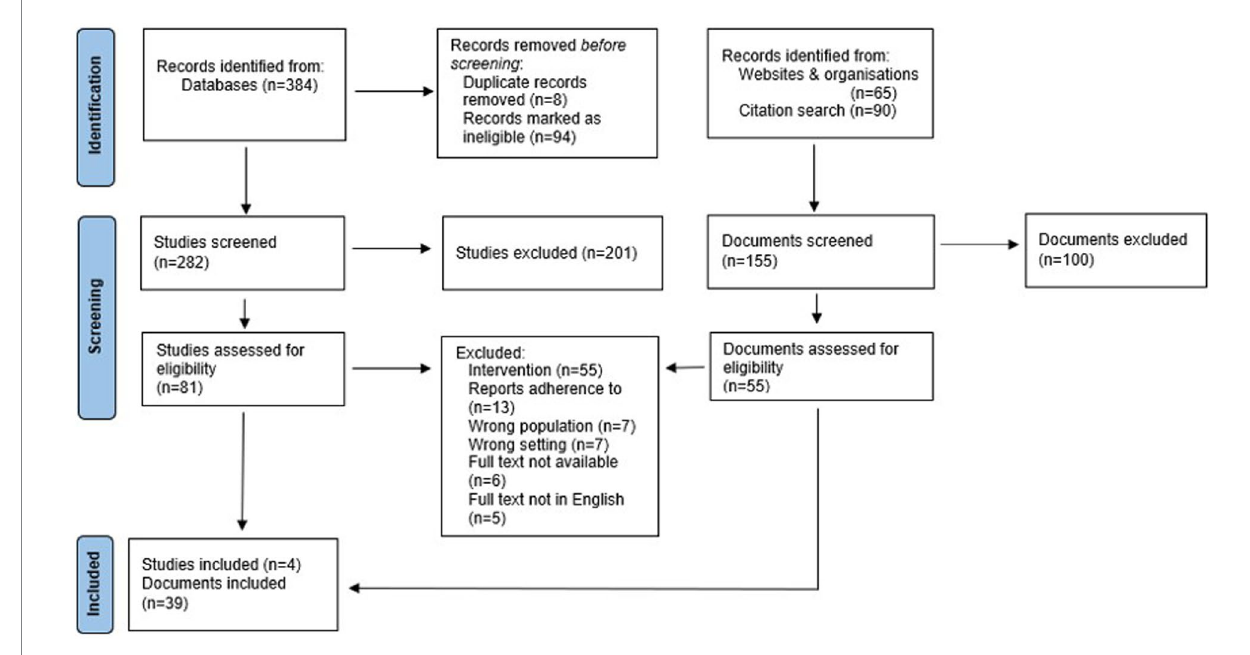
FIGURE 1 PRISMA-ScR